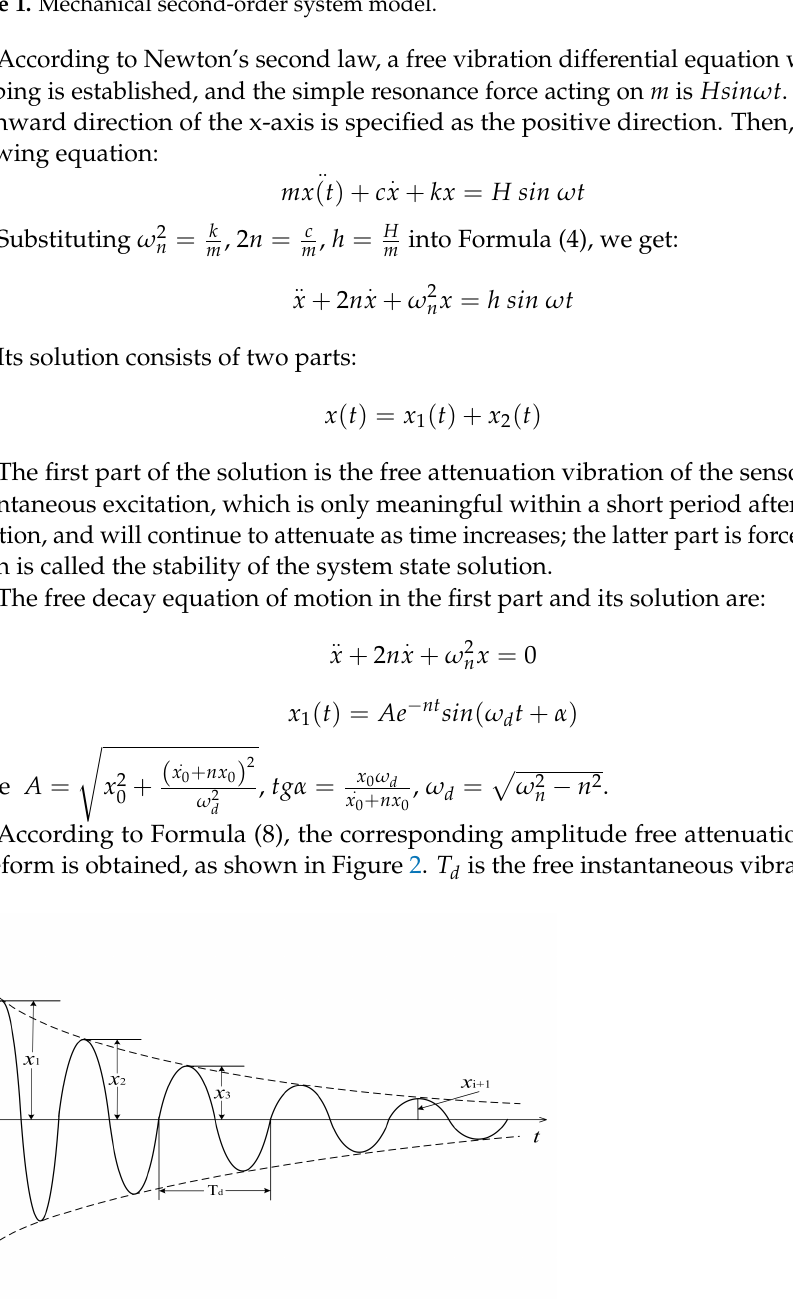
Figure 1. Mechanical second-order system model.